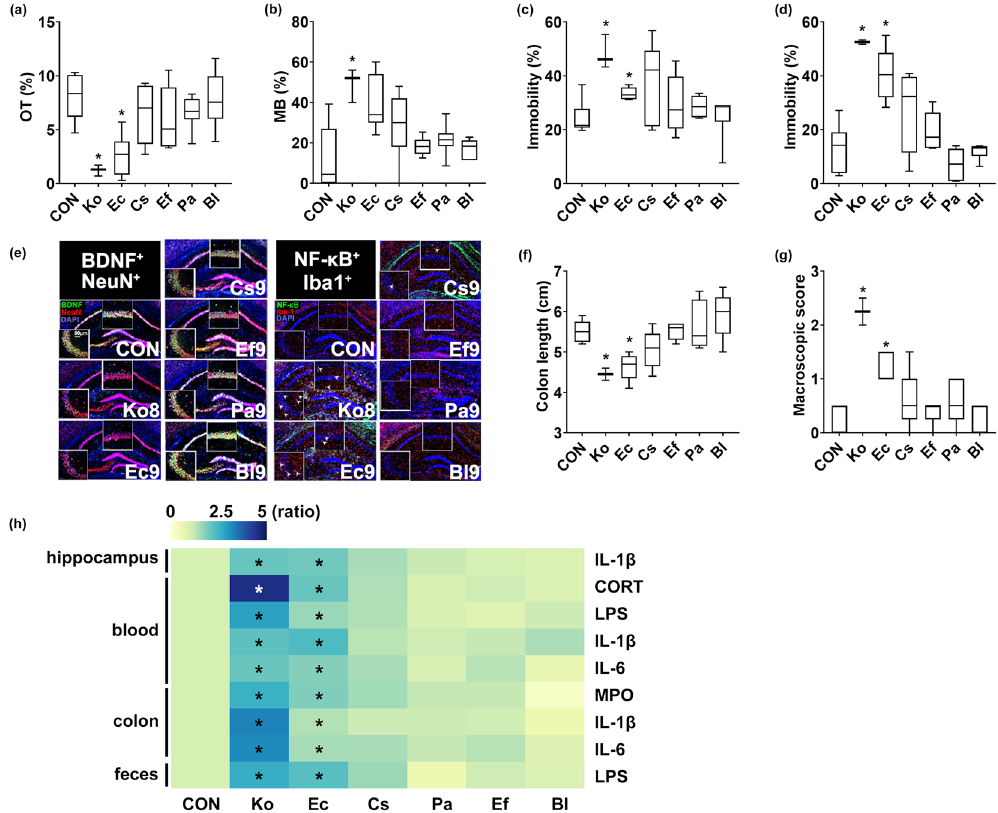
Figure 2. Effect of gut bacteria on the occurrence of anxiety/depression and colitis in mice. Effects on the time spent in open arms (OT) in the EPMT ( a ), marble-buried number in MBT ( b ), immobility time in the TST ( c ), and forced FST ( d ), and effects on the BDNF + /NeuN + and NF-κB + /Iba1 + cell population in the hippocampus ( e ). Effects on the colon length ( f ) and macroscopic score ( g ). ( h ) Effects on the IL-1β, IL-6, LPS, myeloperoxidase (MPO), and corticosterone levels, indicated as compared to control group (CON: 1). Heatmap was generated using Plotly (https:// chart- studio. plotly. com). Klebsiella oxytoca (Ko) , Escherichia coli (Ec), Cronobacter sakazakii (Cs), Enterococcus faecium (Ef) , Pediococcus acidilactici (Pa), or Bifidobacterium longum (Bl) at a dose of 1 × 10 9 CFU/mouse/day was orally gavaged in mice once a day for 5 days. Control mice (Con) were treated with vehicle (saline) instead of the gut bacterial suspension. Data are shown as box plots (n = 6). *p < 0.05 vs Con. Means with same letters are not significantly different (p < 0.05). All were analyzed using unpaired t